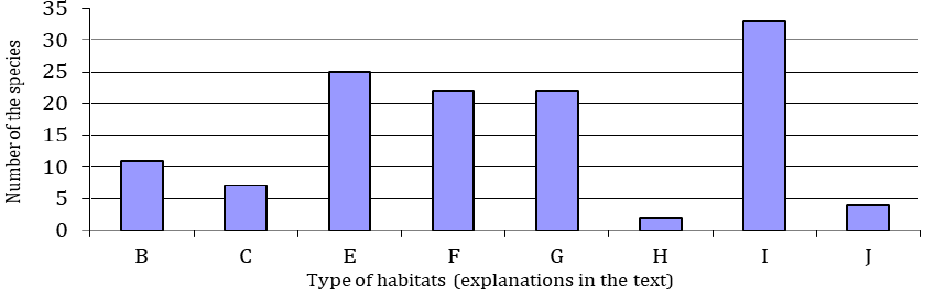
Fig. 4. Distribution of invasive species by their habitat types